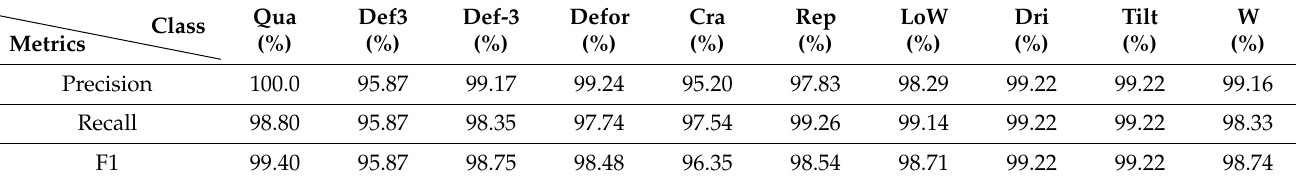
Table 4. Performance metrics of ACGAN-SVM-CNN integrated model in each category.